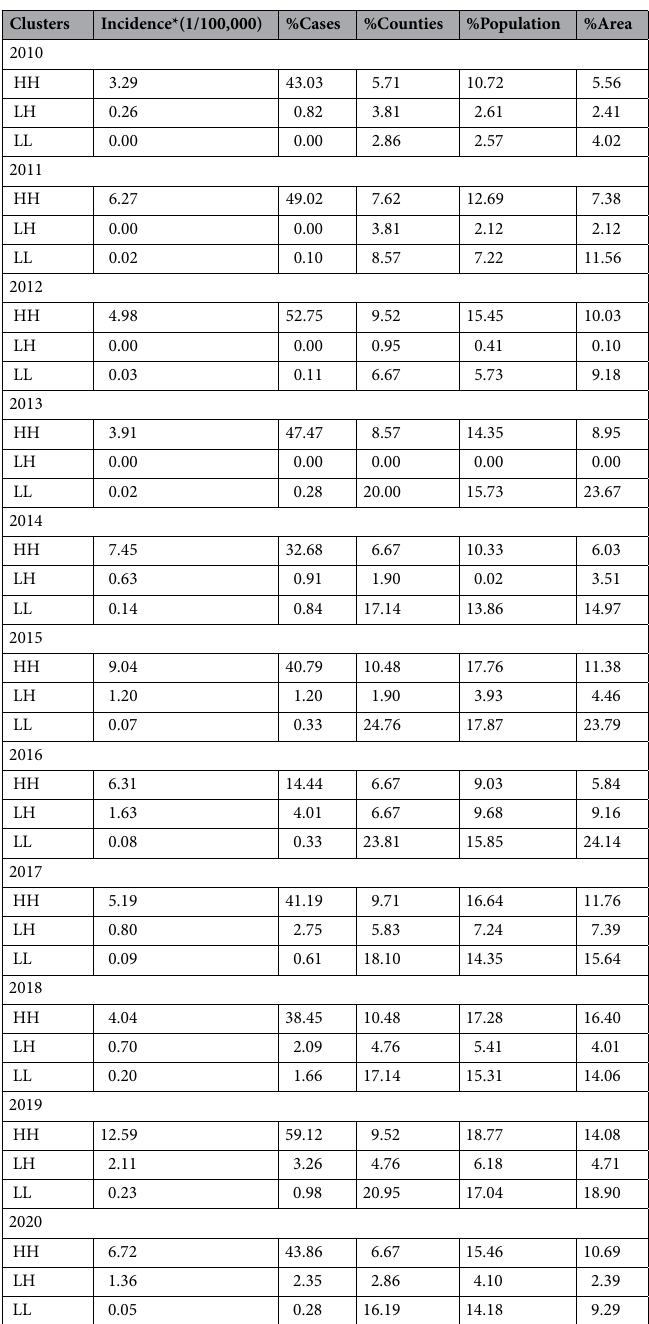
Table 3. Descriptive statistics of spatial clusters detected by LISA analysis in Anhui, 2010–2020. Incidence*: annual average incidence, calculated with the yearly counts of scrub typhus cases as a numerator and population size at the end of each year as a denominator; HH: High-High, a statistically significant cluster of high scrub typhus incidence values; LH: Low–High, low scrub typhus incidence values surrounded with High scrub typhus incidence values; LL: Low-Low, low scrub typhus incidence values surrounded with low scrub typhus incidence